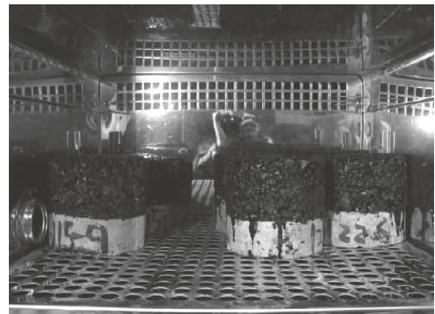
Figure 2: The specimen of the interlaminar shear test.